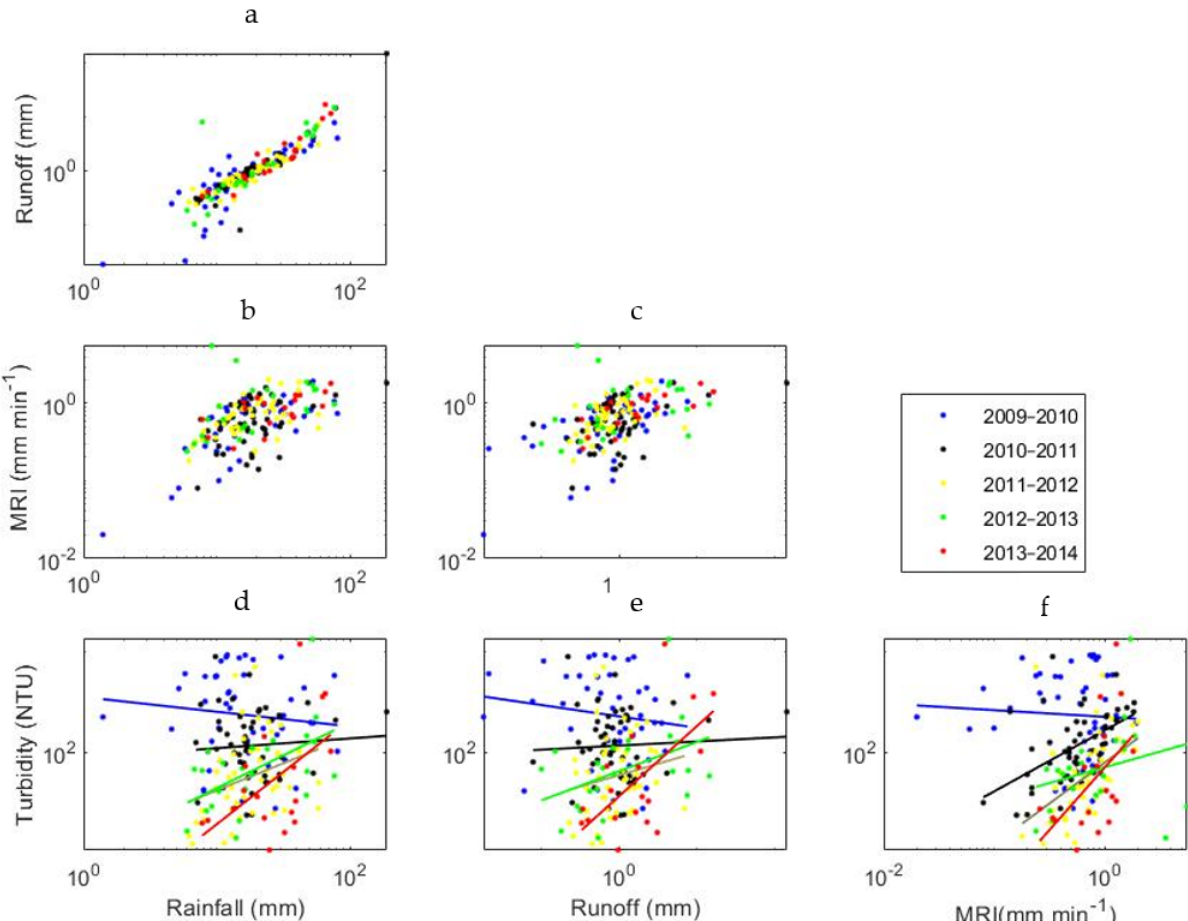
Figure 7. Scatterplots showing data from 186 events: ( a ) rainfall vs. runoff, ( b ) rainfall vs. MRI (maximum rainfall intensity during an event), ( c ) runoff vs. MRI, ( d ) rainfall vs. runoff-weighted turbidity, ( e ) runoff vs. runoff-weighted turbidity and ( f ) MRI vs. runoff-weighted turbidity. The associated R 2 and p -values are listed in Table 1.